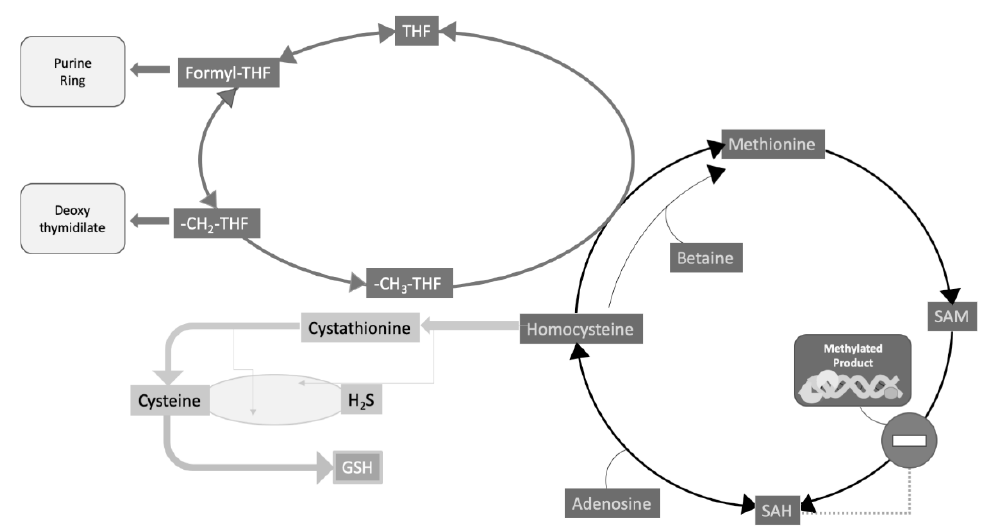
Figure 2. Homocysteine metabolism, folate cycle and methyl transfer reactions. Methionine is supplied by the diet; in that it is an essential amino acid. Homocysteine is generated from methionine through three subsequent reactions: (I) the expensive biosynthesis of S -adenosylmethionine (SAM) by the consumption of all phosphate bonds of ATP; (II) Methyl transfer from SAM to over fifty di ff erent acceptors, including small molecules and macromolecules (nucleic acids and proteins); (III) Hydrolysis of SAM demethylated product: S -adenosylhomocysteine (SAH) yielding adenosine and homocysteine. SAH is a powerful competitive inhibitor of SAM-dependent methyltransferases, therefore its enzymatic disposal is crucial to prevent its buildup within the cell thus creating the conditions for such inhibition to actually take place. (IV) homocysteine in turn can be re-methylated to methionine, though a couple of “rescue” reactions, dependent on either 5 -methyltetrahydrofolate (5 -CH 3 -THF), as the major reaction also requiring cobalamine (vit. B12) as well, or betaine as a